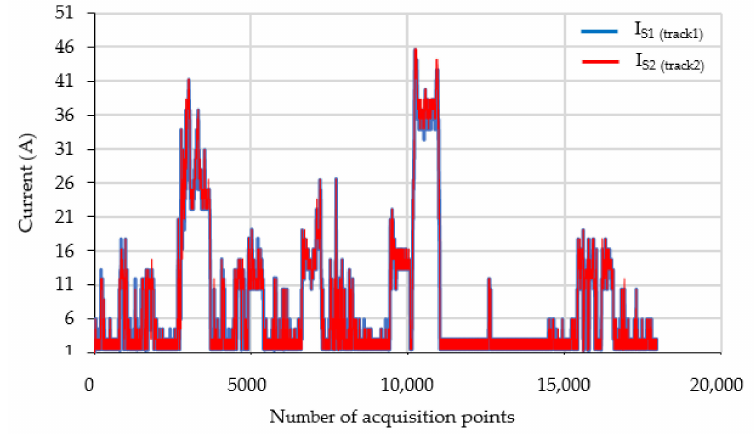
Figure 12. Monitoring the current from return circuit over a period of time.